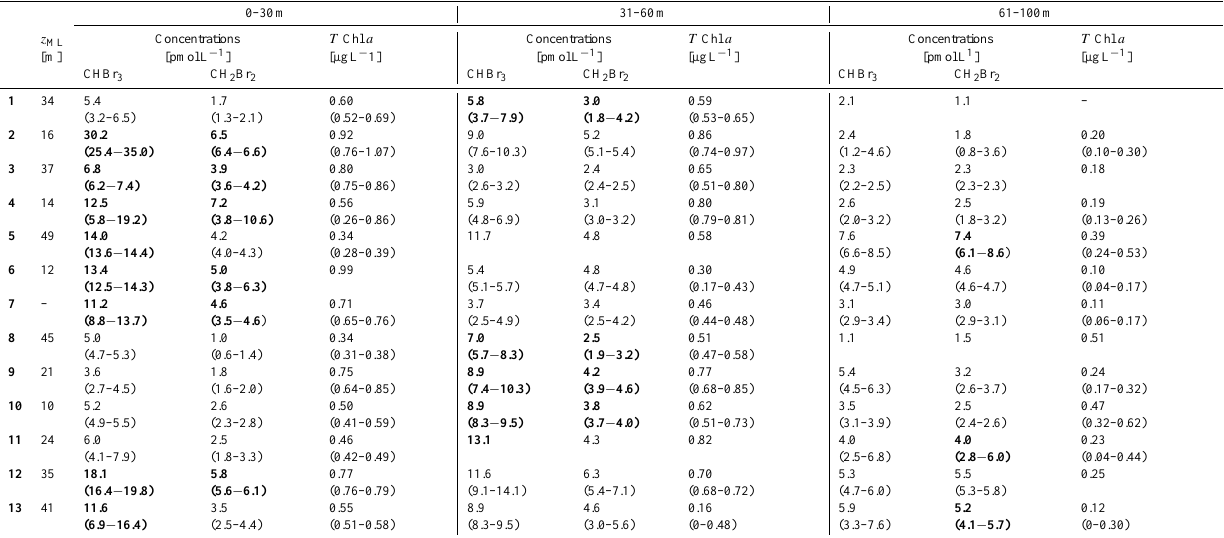
Table 3. Concentrations of CHBr 3 , CH 2 Br 2 and T Chl a (from HPLC measurements) averaged over different depths at every CTD station (1–13), as well as the mixed layer depth. If a range is not given, only one measurement point exists. Bold numbers indicate the depth of maximum concentrations at this